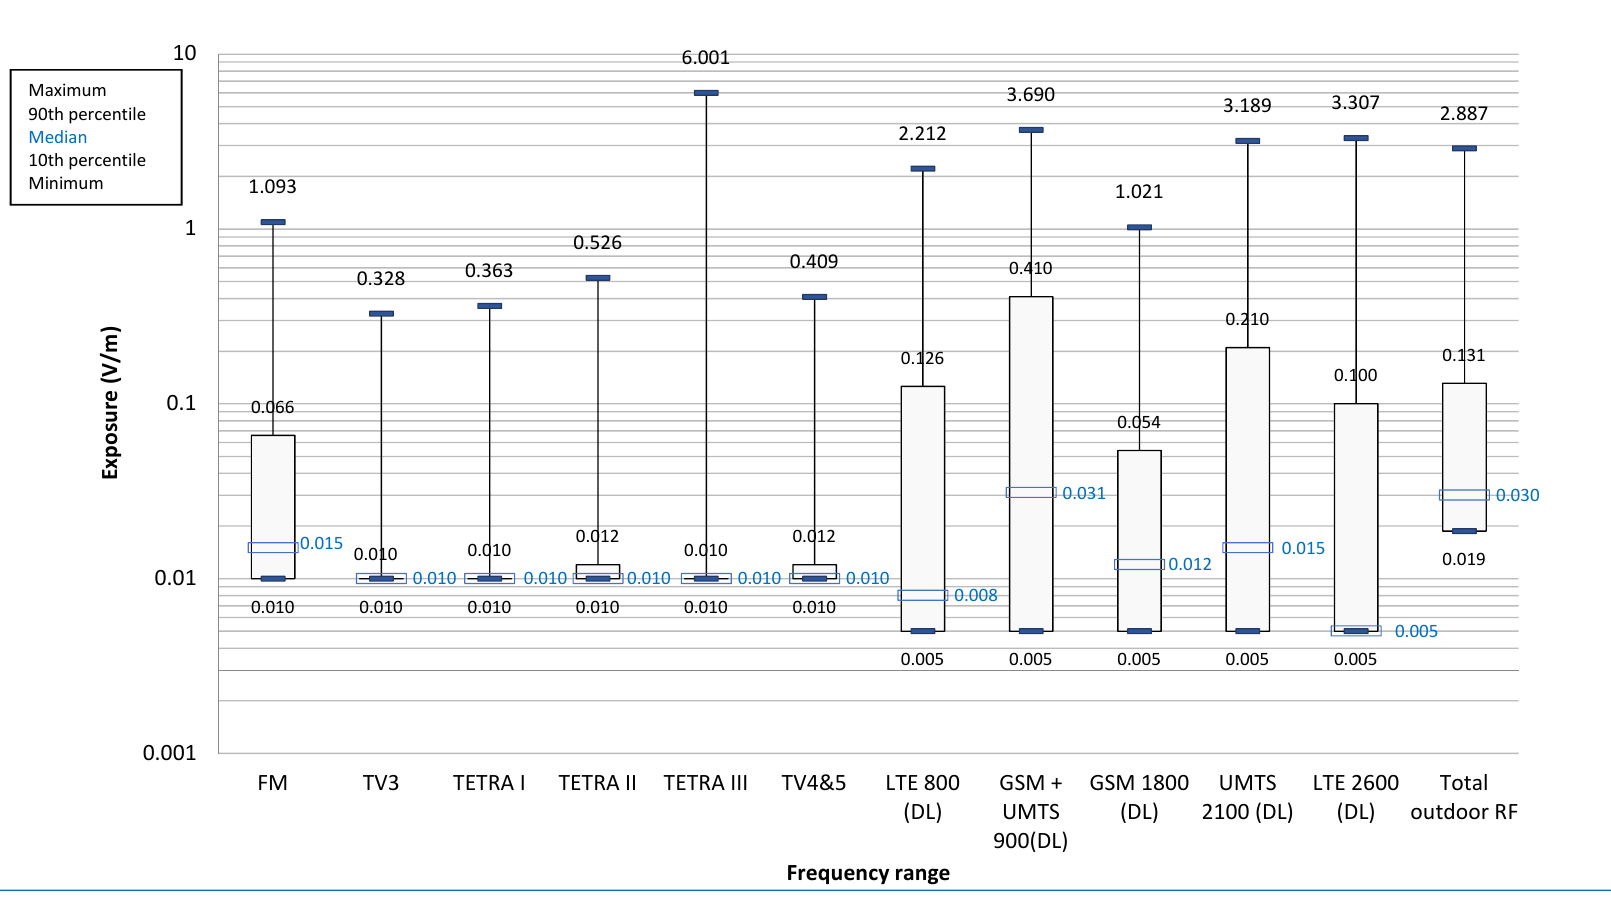
Figure 2. Exposure due to outdoor sources. The minimum value is equal to the detection threshold of 0.01 V/m for frequencies between FM and TV4 and 5, and 0.005 V/m for other frequencies. The value of the minimum is not specified in the graph. For all frequencies it is confused with the 10th percentile.